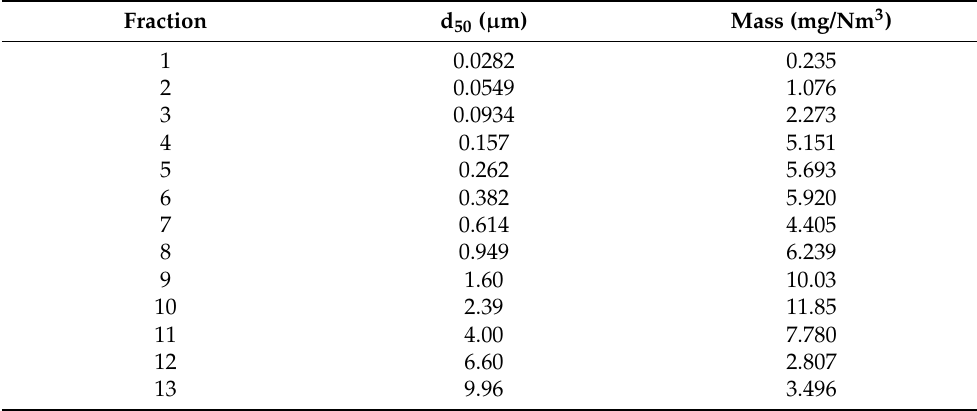
Table A1. Cut-off diameter (d 50 ) and collected weight of each size